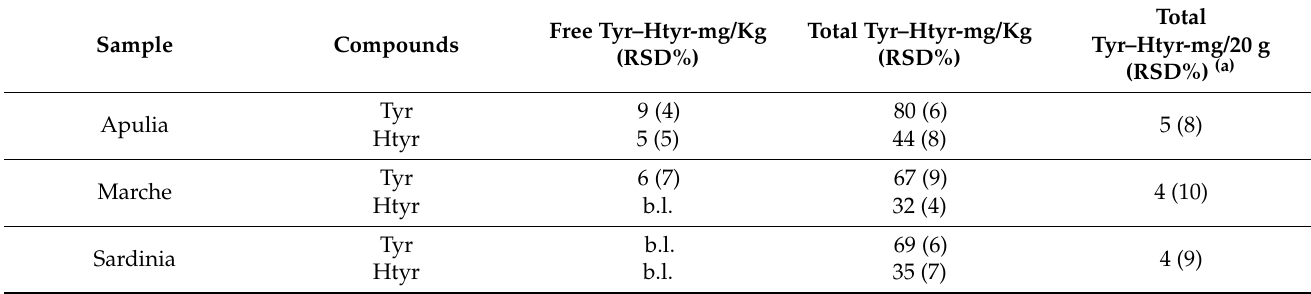
Table 4. Free and total content of Tyr and Htyr in the selected oil samples. Average value of three aliquots for each EVOO sample and relative standard deviation in parentheses. b.l.: below limit of quantification. The analyte total content in 20 mg of EVOO samples are also reported, following the 432/2012 EU